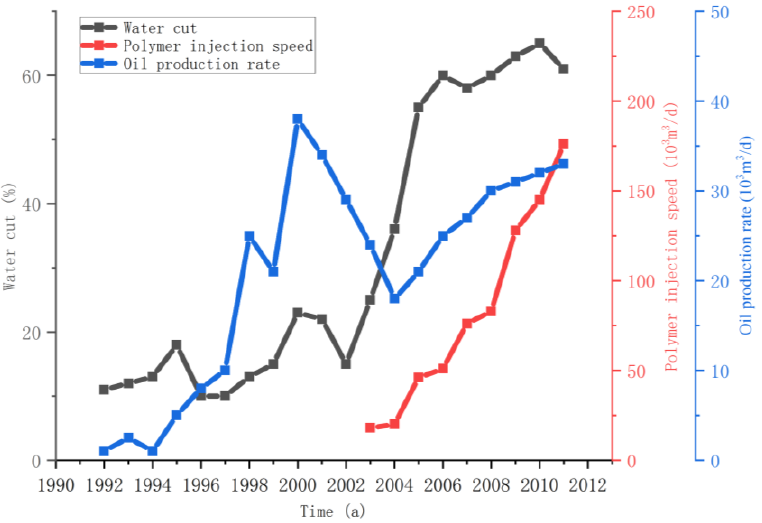
Figure 2. Changes in crude oil production, polymer injection rate, and water cut in A block in Canada over time [89] .